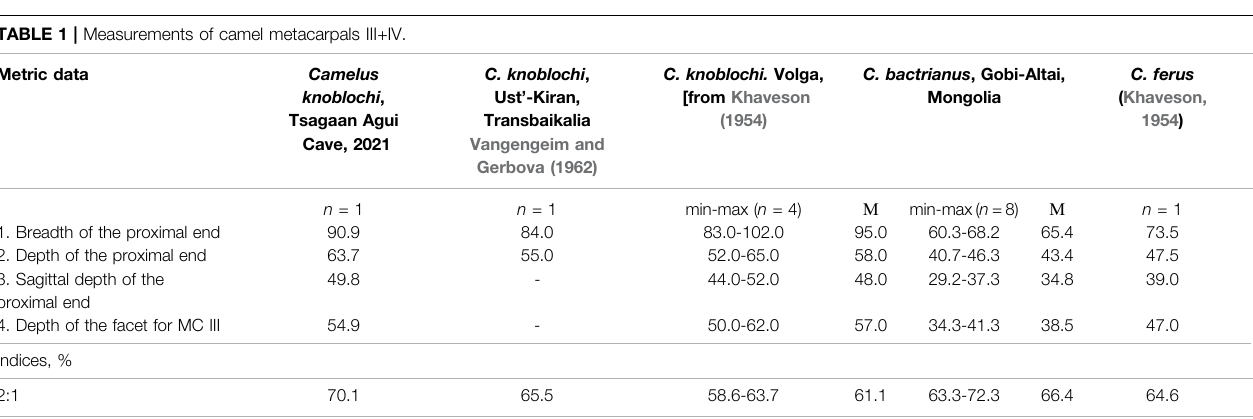
TABLE 1 | Measurements of camel metacarpals